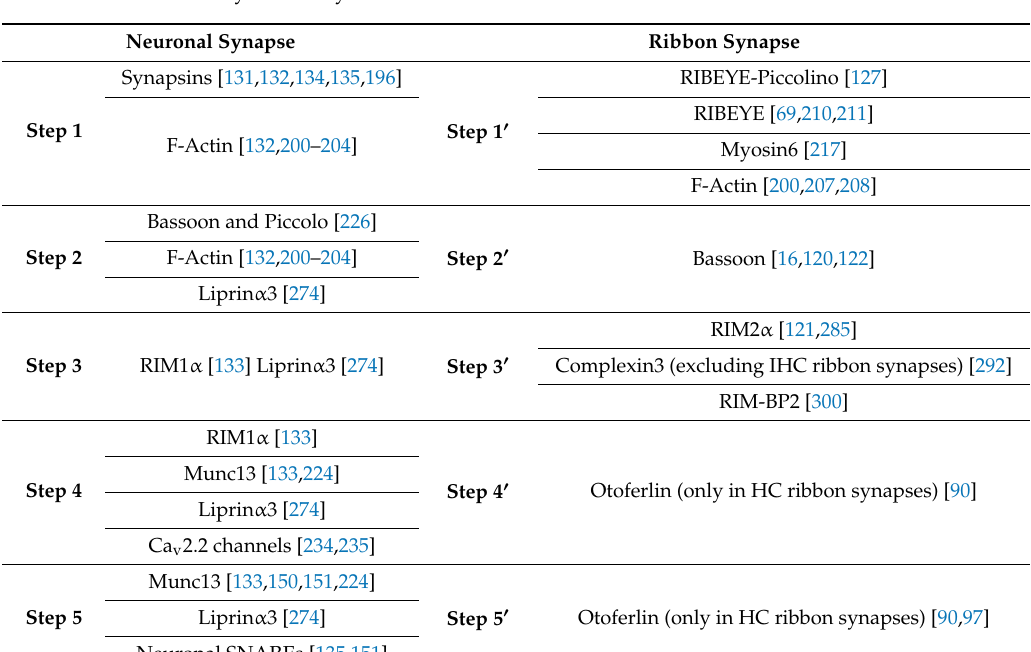
Figure 3. Schematic comparison of potential filament protein candidates at neuronal and ribbon-type synapses. ( A ) At neuronal synapses, the interconnectors cluster SVs away from the AZ membrane (1). Initially, a single long membrane-attached tether mobilizes the SVs (2) and recruits SVs to the AZ membrane (3). Multiple short membrane-attached tethers are then formed (4), preparing SV for docking (5) and fusion. ( B ) At the ribbon-type synapses, interconnectors and ribbon-attached filaments are formed, organizing SVs away from the AZ membrane, and then mobilize SVs (1 (cid:48) ); possibly via the presynaptic density as suggested for the IHC ribbon synapse (2 (cid:48) ). Single membrane-attached tethers are formed (3 (cid:48) ) before multiple-tethering (4 (cid:48) ), and finally, SVs are docked (5 (cid:48) ), and release takes place. Table 1. Possible candidate proteins directly or indirectly involved in filament formation at di ff erent stages of exocytosis. Depicted are candidate proteins, which could assist in the formation of di ff erent filaments like interconnectors, ribbon-attached filaments and membrane tethers (also shown in Figure 3). Noteworthy, for most of the studies, it is unknown, whether the protein candidates are an integral part of the filaments or only indirectly influence the filament number and amount of connected